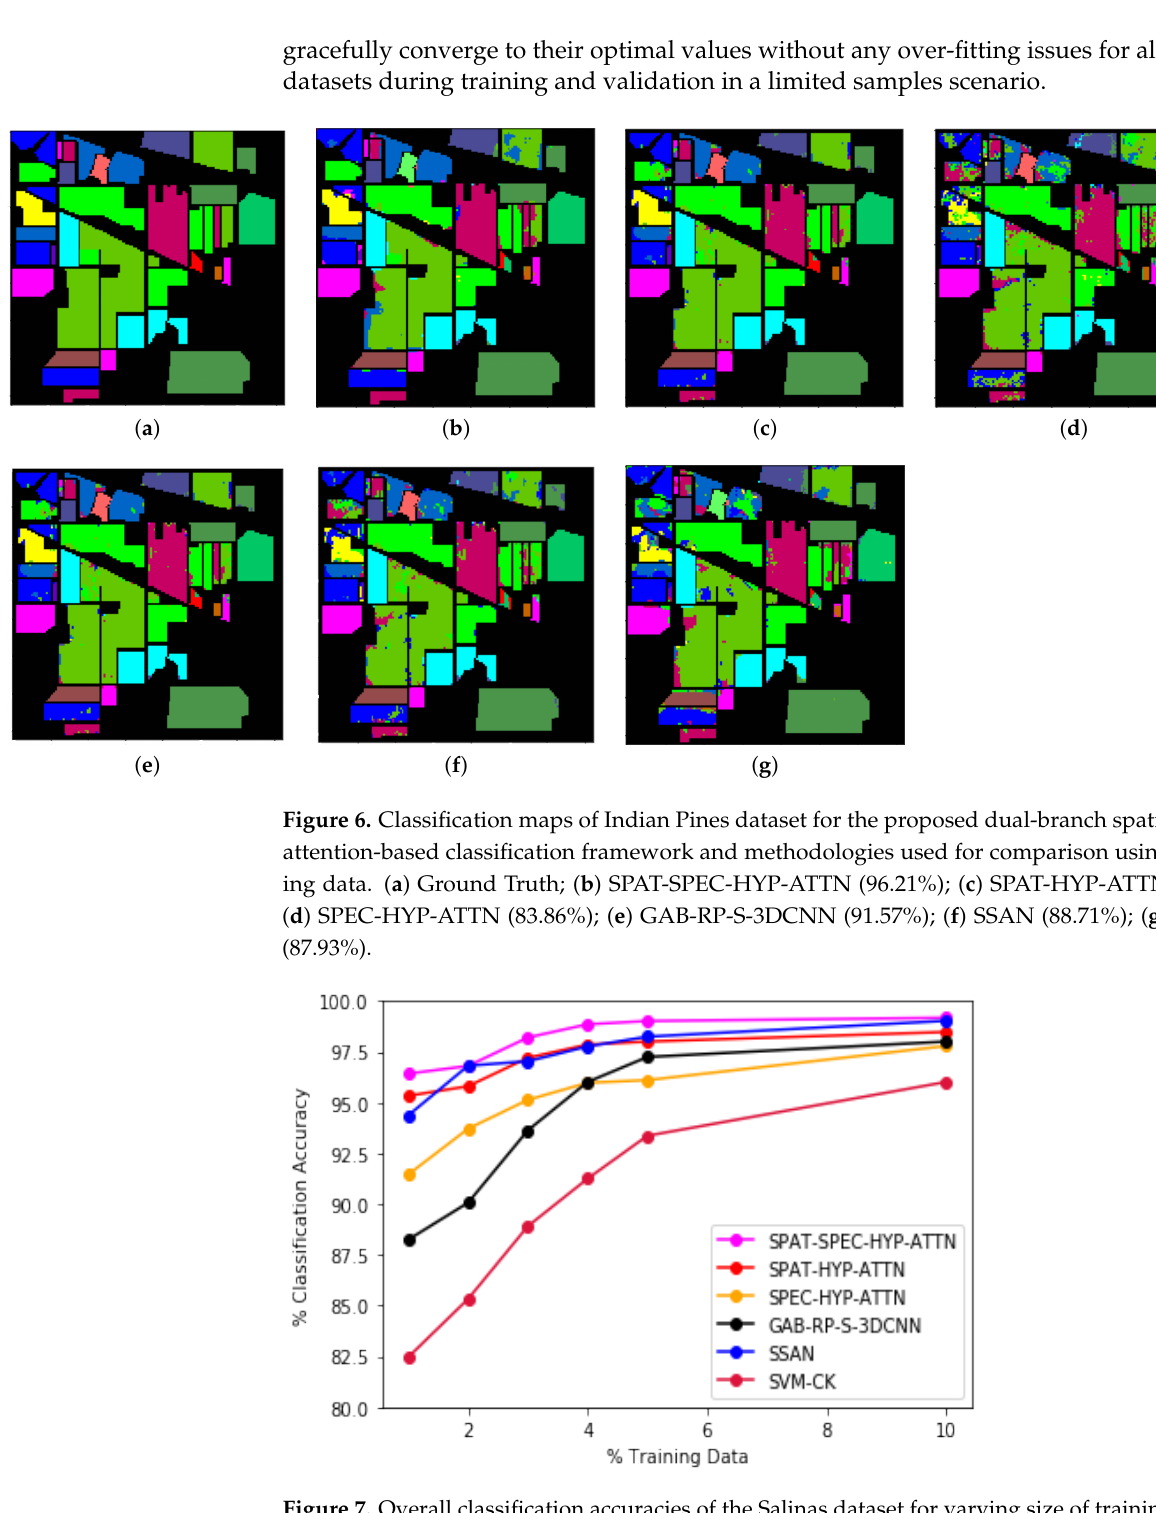
Figure 7. Overall classification accuracies of the Salinas dataset for varying size of training